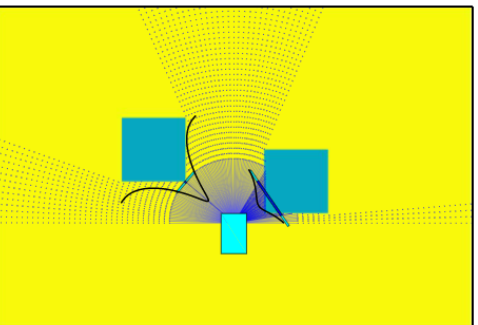
Figure 2. Illustration with vehicle and obstacles of the laser range finder (LRF) sensor.